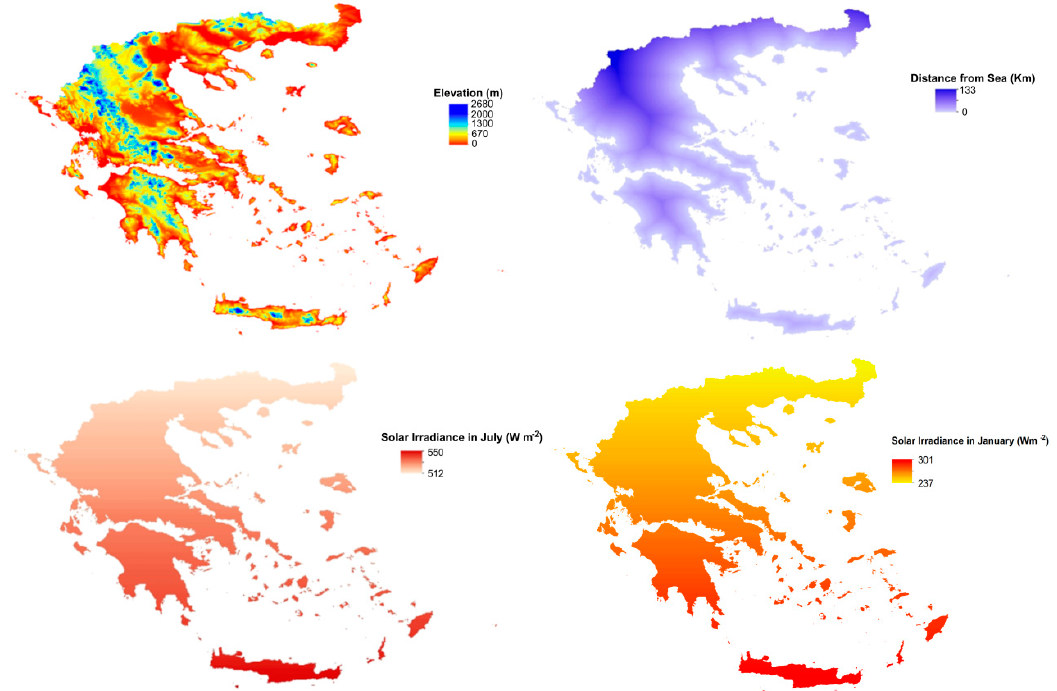
Figure 5. Main geophysical parameters used in MISH as predictors: elevation (m), Euclidean distance from the coastline (km), and solar irradiance (W / m 2 ) for the months of January and July.